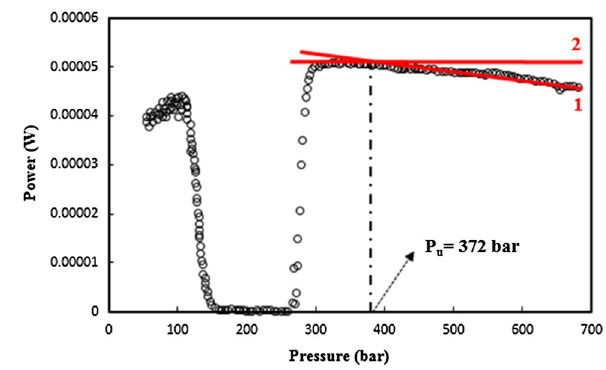
Fig. 28 Results of LST on Y3 oil sample at 413 K (Buenrostro-Gon- zalez et al.